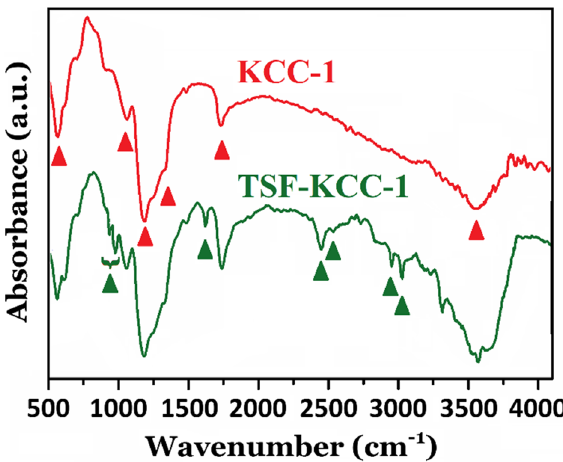
Figure 1. FTIR spectra of pure KCC-1 and TSF-KCC-1